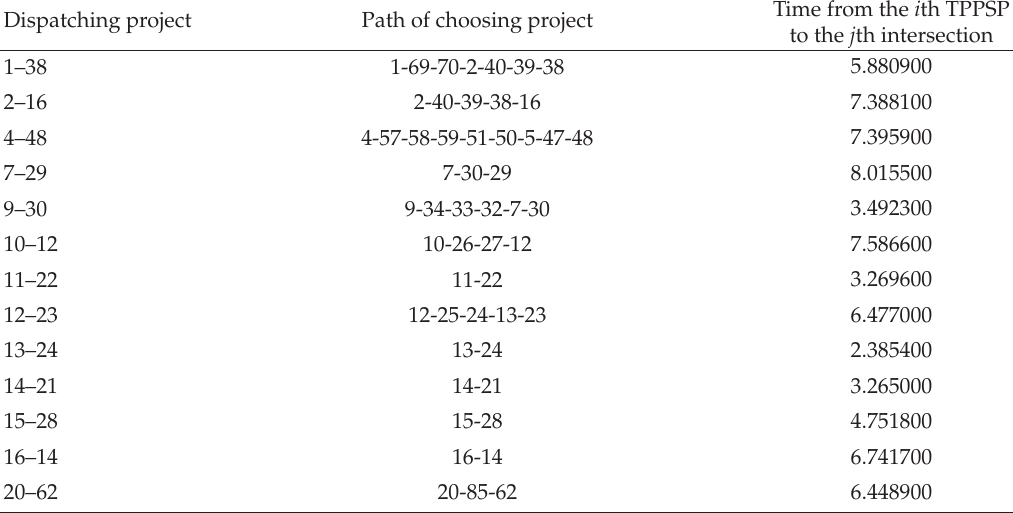
Table 1: The optimal dispatch project of TPPSP without any tra ffi c congestion.